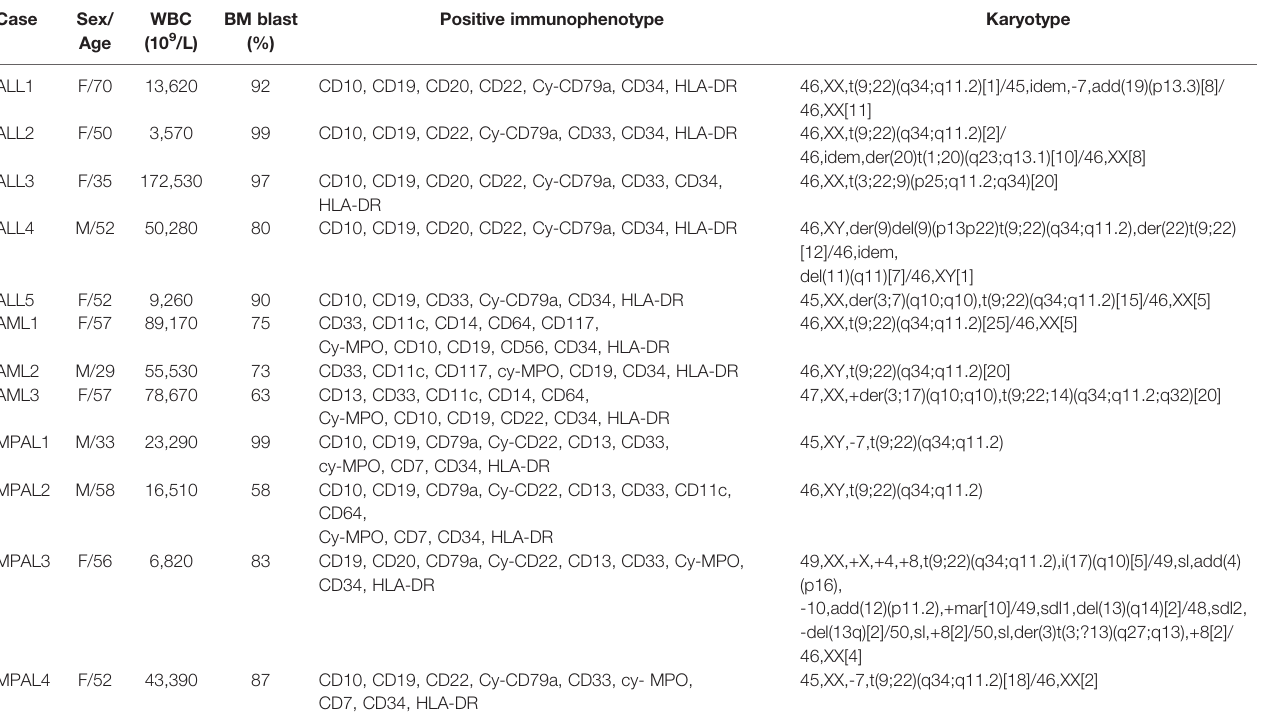
TABLE 1 | Characteristics of patients at